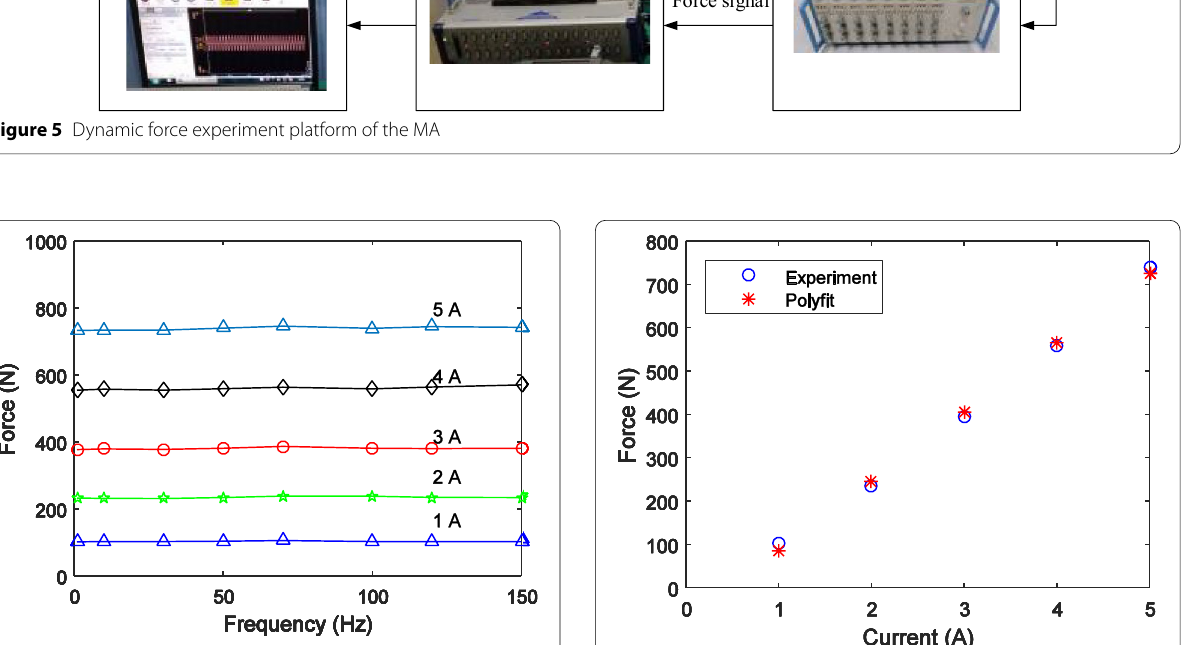
Figure 6 Dynamic force test results of the MA